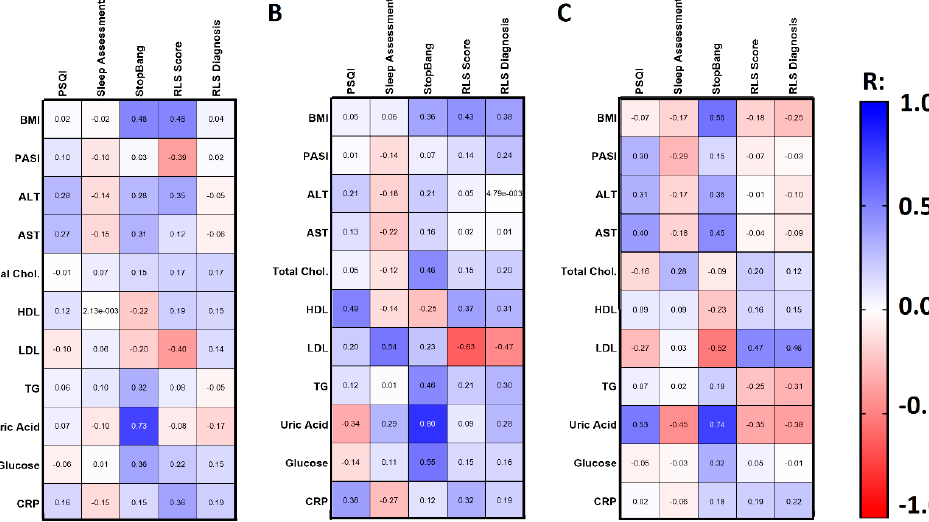
Figure 2. Spearman’s rank correlations between chosen basic clinical data and sleep patterns scores in psoriatic patients’ group ( A ), PASI I subgroup ( B ), and PASI II subgroup ( C ). Numbers on the graphs present R rank values. The blue color indicates the existence of a positive correlation between analyzed parameters, whereas the red color stands for the negative dependencies. BMI, body mass index; PASI, psoriasis area and severity index; TGs, triglycerides; HDL, high- density lipoproteins; LDL, low-density lipoproteins; CRP, C-reactive protein; ALT, alanine transaminase; AST, asparagine transaminase; PSQI, Pittsburgh Sleep Quality Index; RLS, restless legs